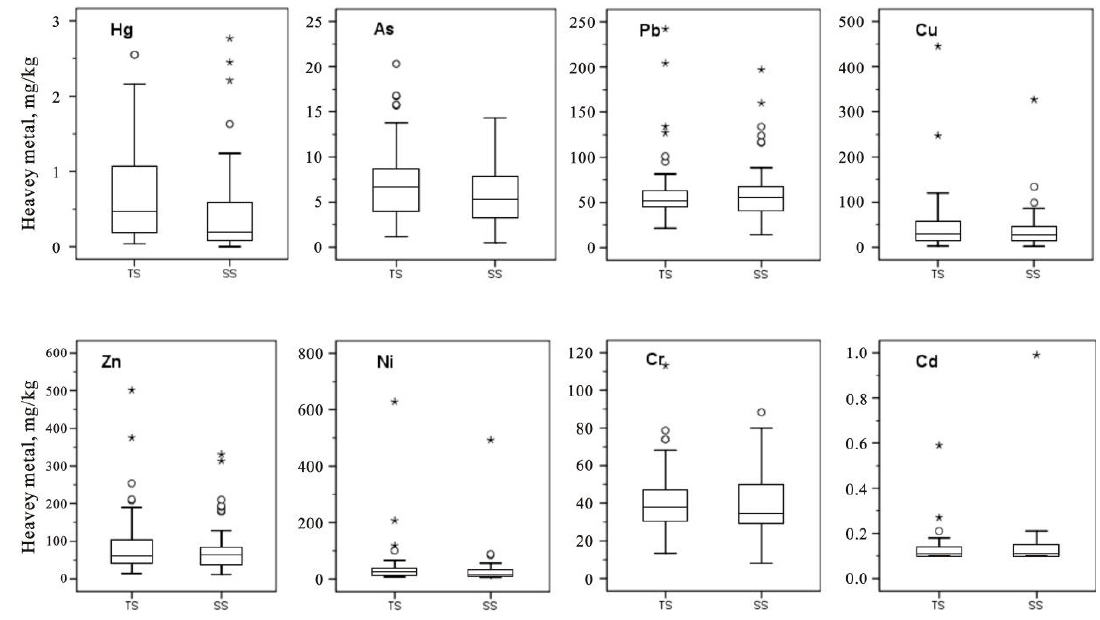
Figure 2. Heavy metal concentrations of soil from the vicinity of industrial sites in Dongguan. TS: topsoils of 0–20 cm, SS: shallow soils of 20–50 cm. The circle symbols ( ○ ) represent outliers (mild outliers), and the cross symbols (*) represent extremes (extreme outliers). The horizontal lines at the top, middle and bottom of the box plot correspond to the 75th percentile, median and 25th percentile, respectively.